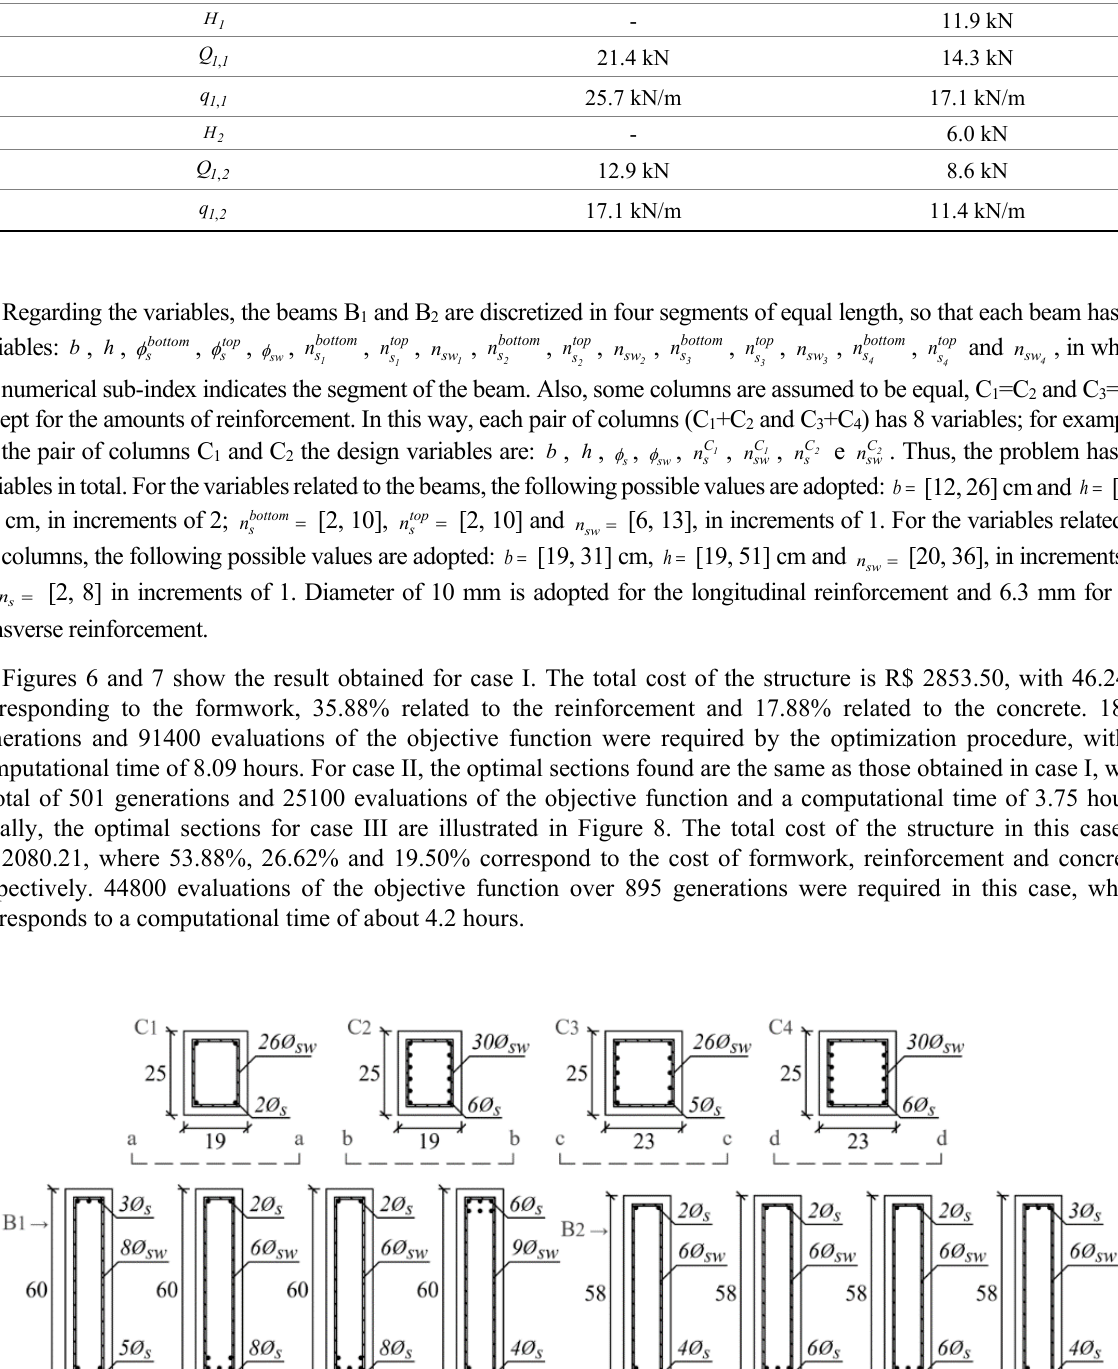
Table 2. Characteristic loads - Example I. Characteristic loads